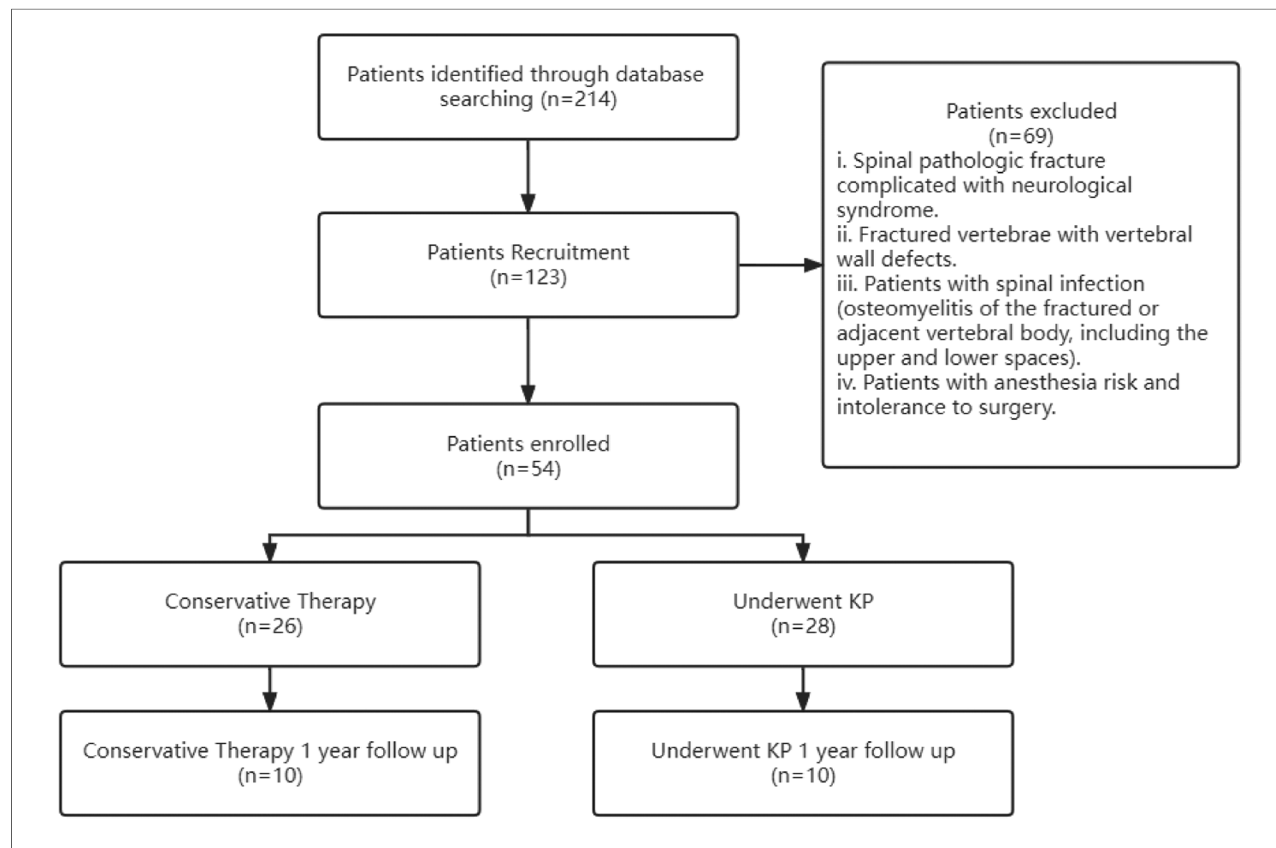
FIGURE 1 The fl owchart of patient eligibility screening and follow-up.